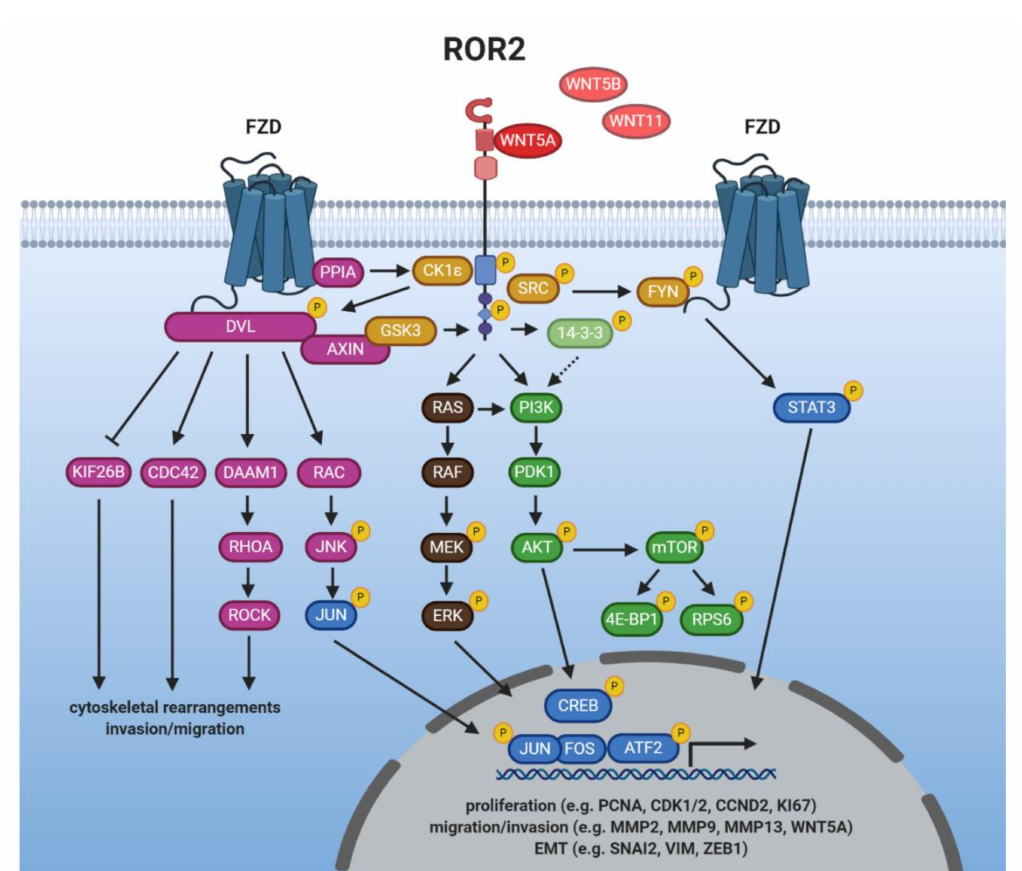
Figure 3. ROR2 signaling. Binding of a non-canonical WNT ligand induces the association of ROR2 with a FZD receptor (e.g., FZD2, 5, 7), or other WNT co-receptors (e.g., PTK7, ROR1). ROR2 activation is triggered by its interplay with several kinases (orange). The signal is then relayed to downstream pathways including WNT/PCP (magenta), PI3K/AKT (green), or MAPK/ERK (brown). Active WNT/ROR2 signaling results in the nuclear translocation and activation of transcription factors (blue) that mediate the expression of target genes associated with cell proliferation, survival, or